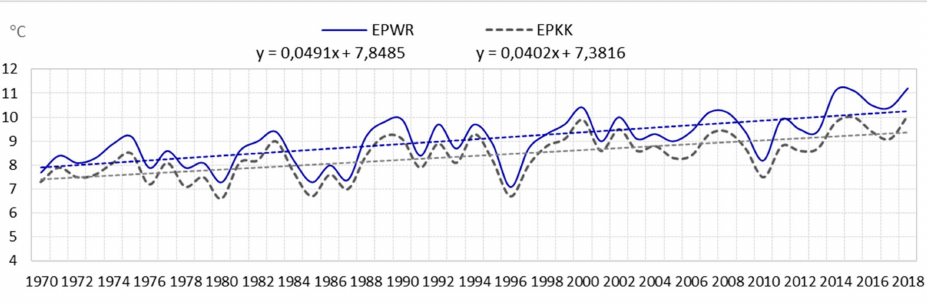
Figure 11. Average annual air temperature and linear trend in EPWR and EPKK